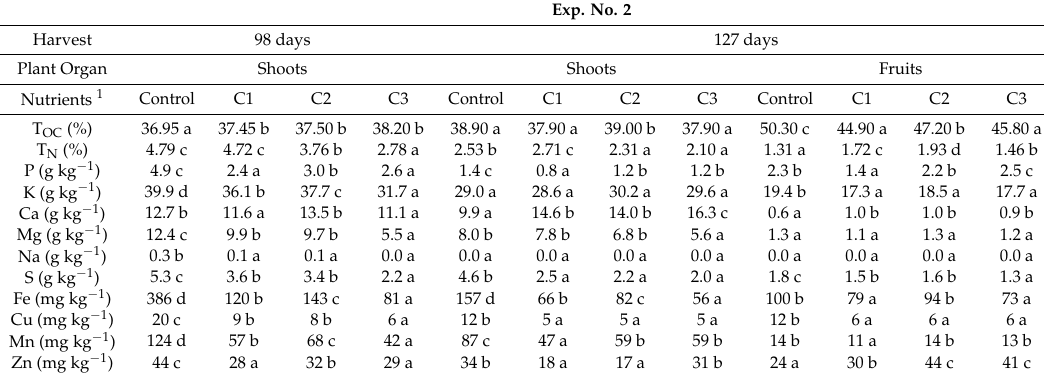
1 Data based on dry weight. Note: Data represent the mean of eight independent replicates. For each nutrient, harvest and plants organ, values followed by the same lower-case letter among treatments (Control, C1, C2,